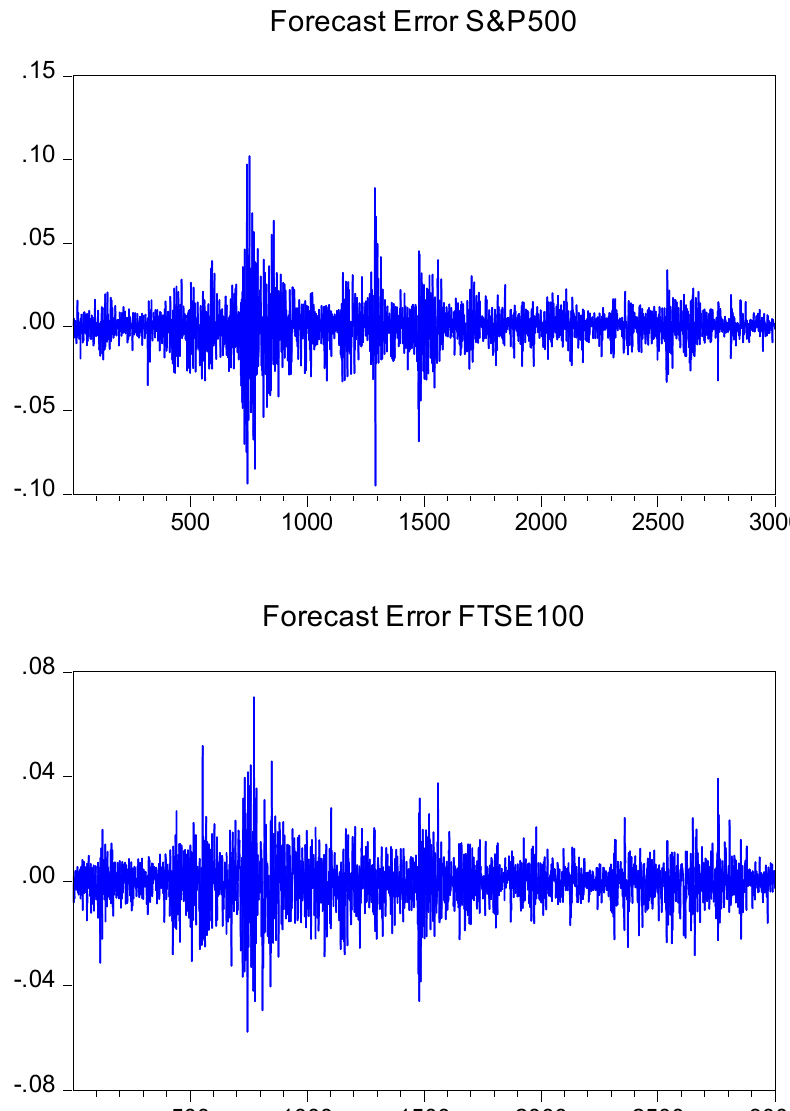
Figure 3. Forecast errors plots. Note: This set of figures depicts the one-step-ahead forecast error of the expected returns in S&P500 and FTSE100 indices used in this study obtained from a rolling-estimation window of 1000 observations.